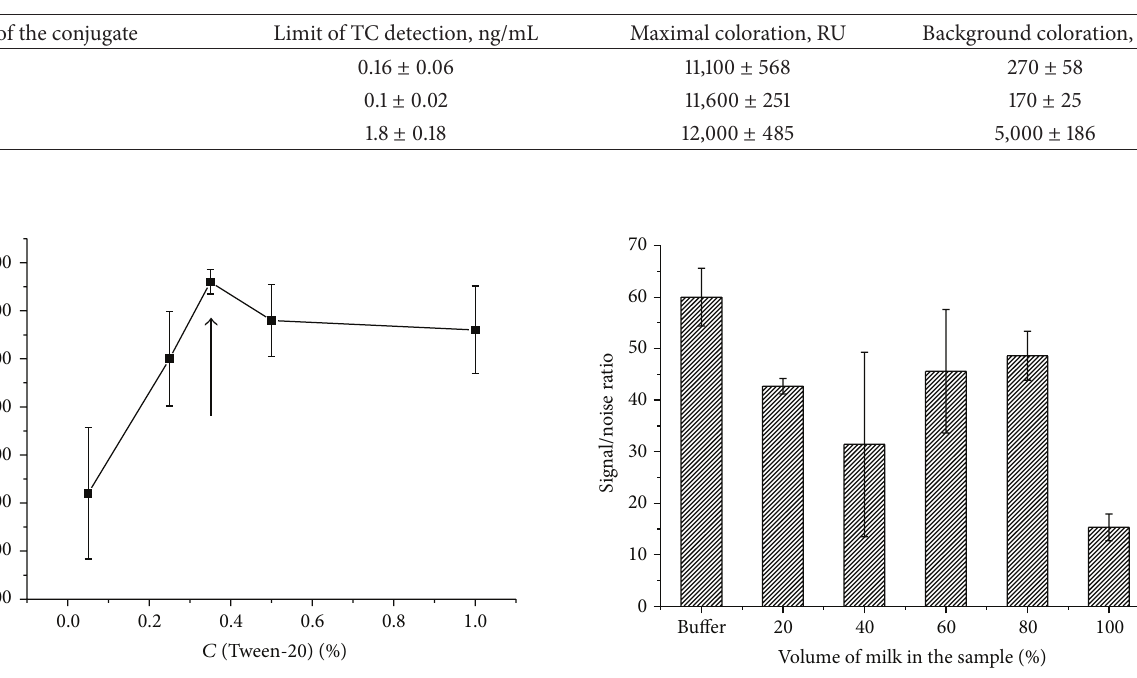
Figure 9: The dependence of the intensity of coloration of the test zone of IC test systems in the absence of TC on the degree of dilution of milk samples using buffer